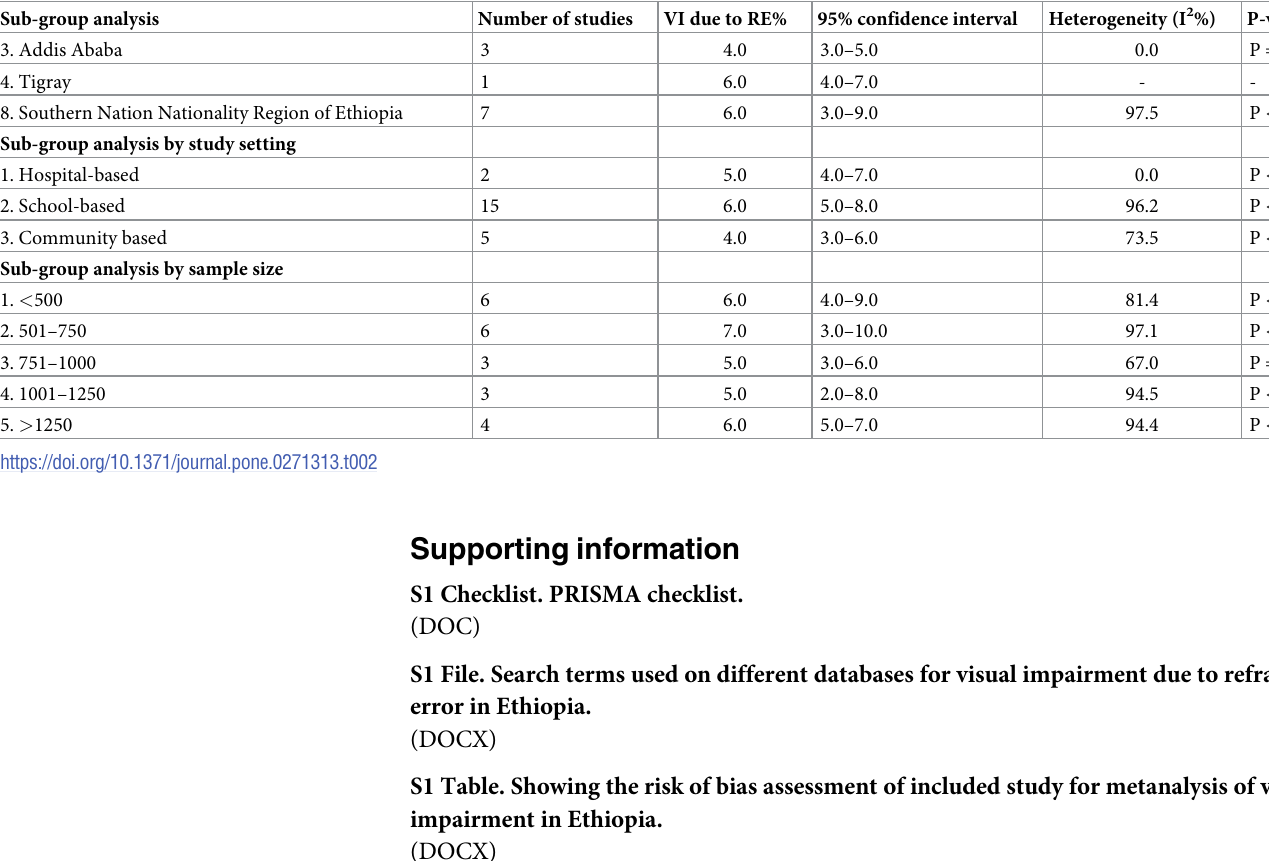
S1 Table. Showing the risk of bias assessment of included study for metanalysis of visual impairment in